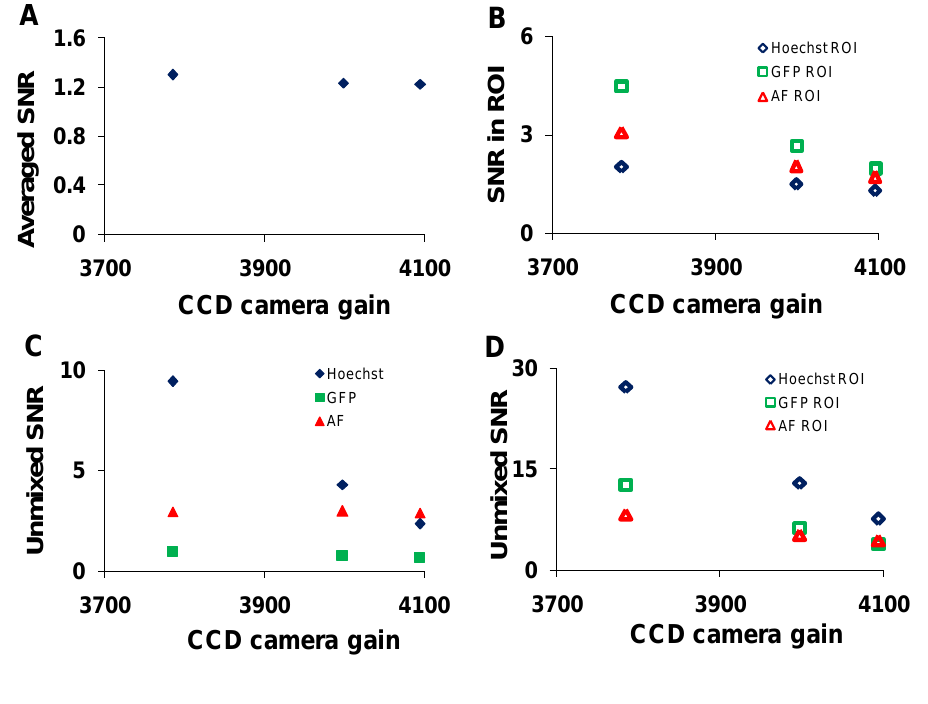
Figure 8. Electron-multiplied charge coupled device (EMCCD) gain (at constant signal level, achieved by decreasing the arc lamp intensity) resulted in decreased signal-to-noise ratio (SNR) for hyperspectral widefield images. ( A ) The wavelength-averaged SNR for an entire field of view; ( B ) the wavelength-averaged SNR for selected regions of interest (ROI) that contained high fluorescence emission from one of the spectral components (Hoechst, green fluorescent protein (GFP), autofluorescence (AF)); ( C ) the SNR averaged over an entire field of view for linearly unmixed images; ( D ) the SNR for the same ROI as B, but for linearly unmixed